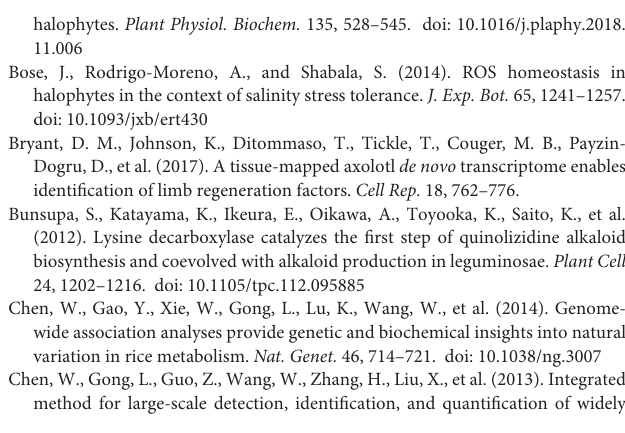
Supplementary Figure 1 | Salinity influence on phenotypic characteristics of S . argel seedlings after 3-days treatment in a greenhouse. Control: control seedlings, treated: seedlings treated with 500 mM NaCl for 3